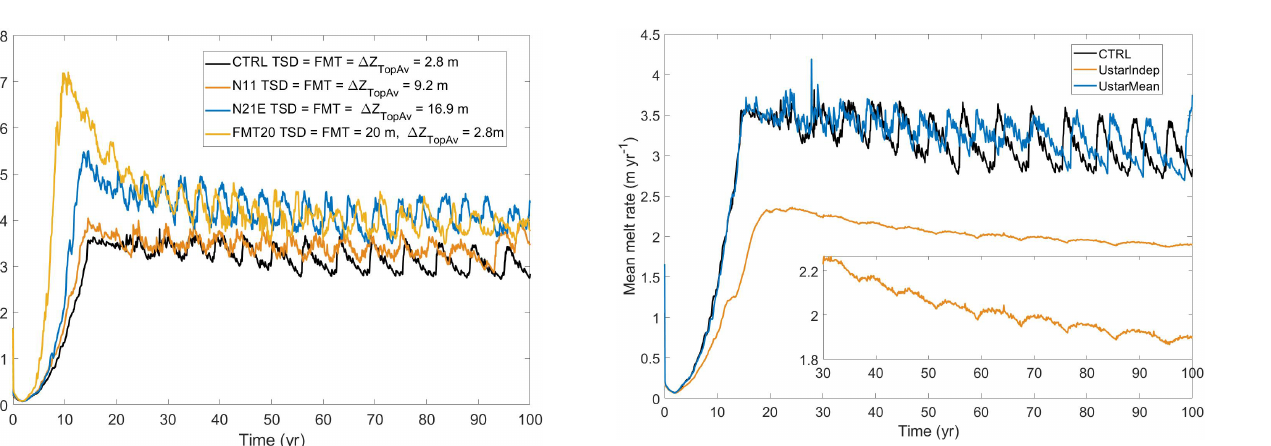
Figure 7. Simulated mean melt rates with different vertical resolu- tions (spatially averaged top layer thickness (cid:49)Z TopAv ), and the im- posed depths for mixing fluxes (flux mixing thickness; FMT) and sampling tracers (tracer sampling distance; TSD).